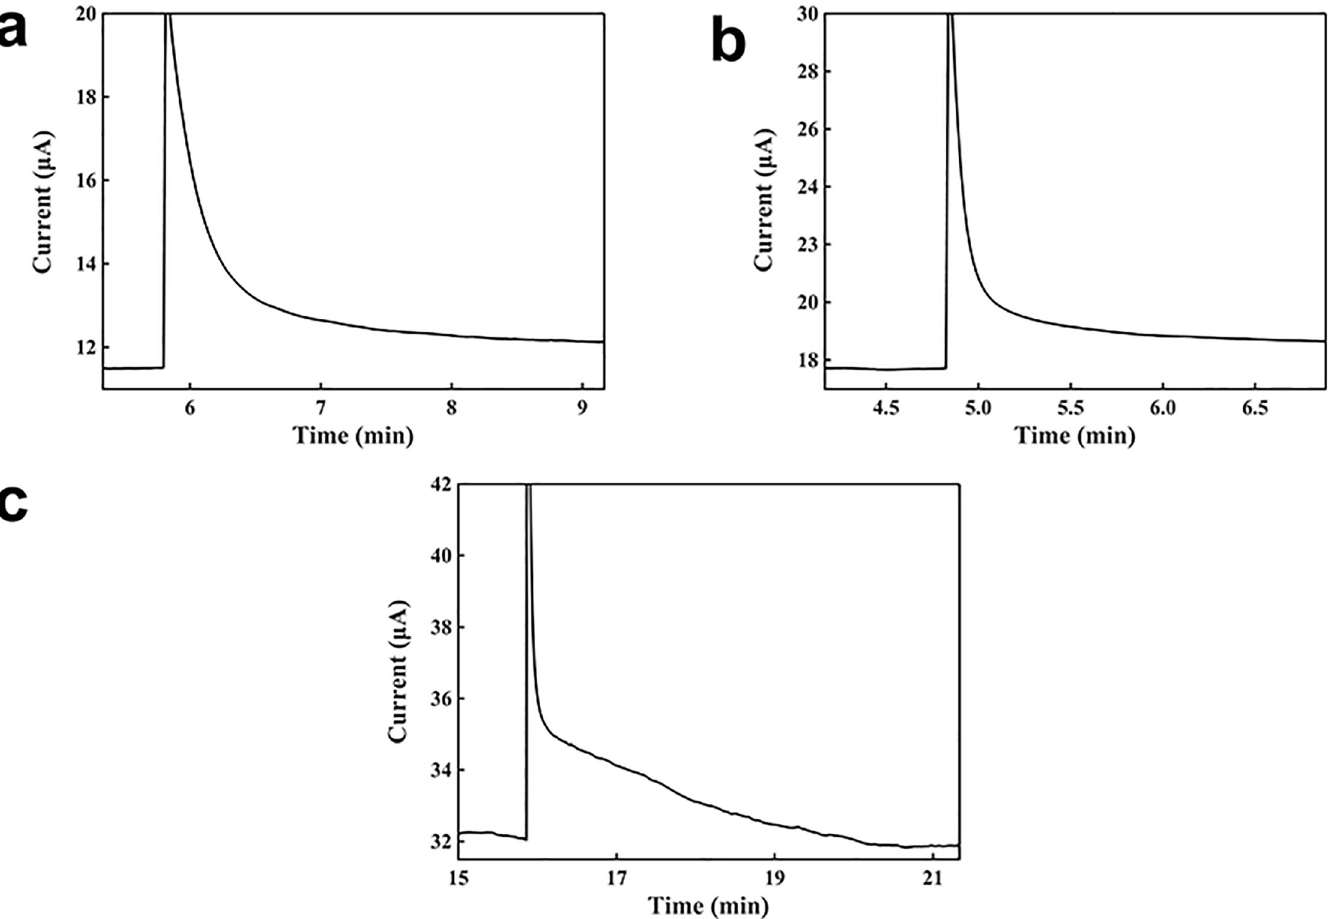
Fig 3. Study of different buffer concentrations with the battery powered sensor system. (a) A response curve for H 2 O 2 with 0.5 mM buffer. (b) A response curve for H 2 O 2 with 2 mM buffer. (c) A response curve for H 2 O 2 with 50 mM buffer. H 2 O 2 concentration in the buffer: 0.05 mM.